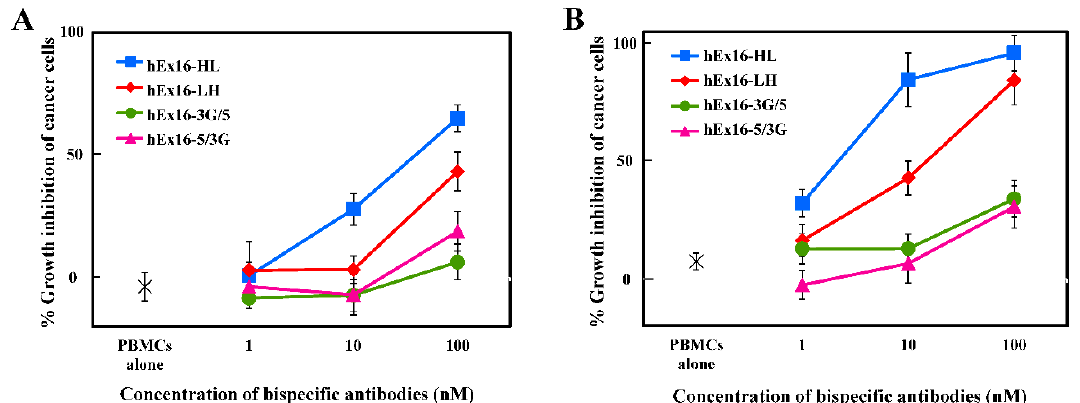
Figure 2. Growth inhibition of EGFR-positive TFK-1 cells by hEx16-Dbs. The purified hEx16-Dbs were added with peripheral blood mononuclear cells (PBMCs) to TFK-1 cells and growth inhibition was evaluated using the MTS assay. The ratio of TFK-1:PBMC was either ( A ) 1:30 or ( B ) 1:80.